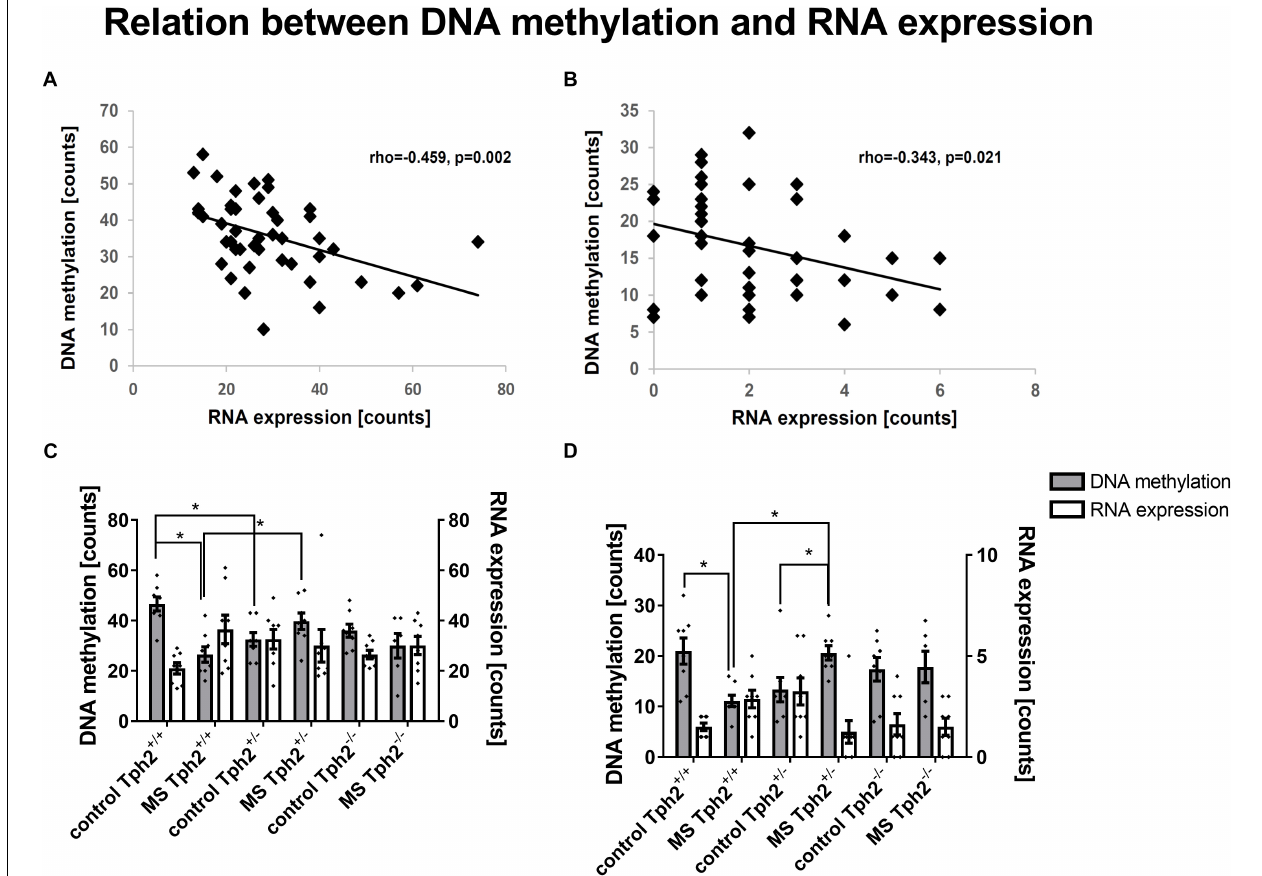
FIGURE 5 | DNA methylation- and RNA expression-related correlations in amygdala. Amongst differentially expressed genes that are furthermore associated with differentially methylated loci, (A) the RIKEN DNA A830073O21Rik and (B) the neuropeptide cholecystokinin ( Cck ) are correlated amongst each other. Data based on sequencing counts of total RNA and methyl-CpG-binding domain (MBD) capture-based, enriched loci ( n /group = 6–8). Correlation analysis was performed using the non-parametrical Spearman correlation ( n /group = 5–8). Spearman correlation coefficient rho and p -value are reported. For both genes A830073O21Rik (C) and Cck (D) the comparison GE1 [( Tph2 + / − MS- Tph2 + / − C)-( Tph2 + / + MS- Tph2 + / + C)] with a significant difference between effect of neonatal, maternal separation (MS) compared to control in tryptophan hydroxylase 2 ( Tph2 ) heterozygous mice and wildtype mice became apparent. Post hoc analysis revealed mainly group differences for A830073O21Rik and Cck methylation ( n /group = 6–8). ∗ FDR-corrected p < 0.050 ( Post hoc : Mann-Whitney U